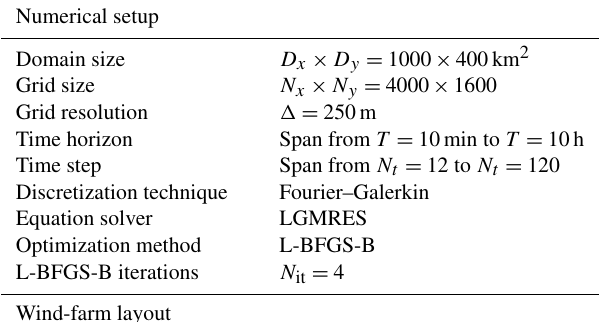
Table 1. Numerical setup, wind-farm layout and atmospheric state used in this